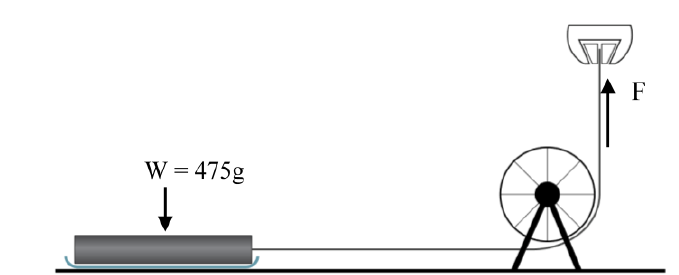
Figure 2. Experimental setup for friction study—modified from ASTM D1894 experimental